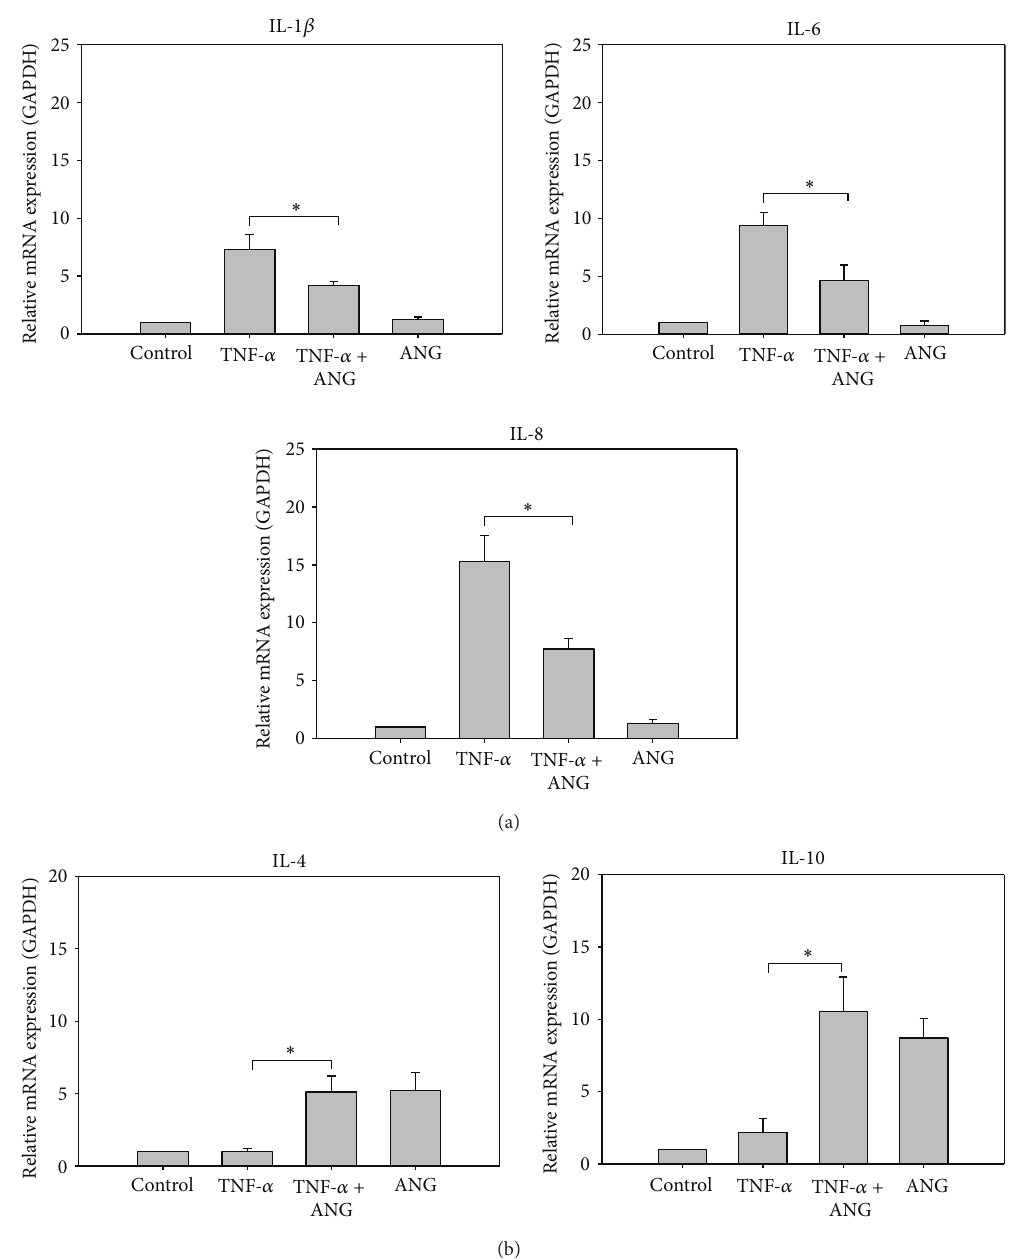
Figure 1: Real-time PCR analyses of proinflammatory cytokines and anti-inflammatory cytokines in HCFs. (a) The relative level of IL-1 𝛽 , -6, and -8 mRNA was diminished by ANG treatment. ANG treatment alone did not affect the mRNA expression of proinflammatory cytokines. (b) The relative expression of IL-4 and -10 mRNA was increased by ANG treatment. ANG treatment alone increased the mRNA expression of IL-4 and -10. The experiments were performed in triplicate ( ∗ 𝑃 < 0.05 ).